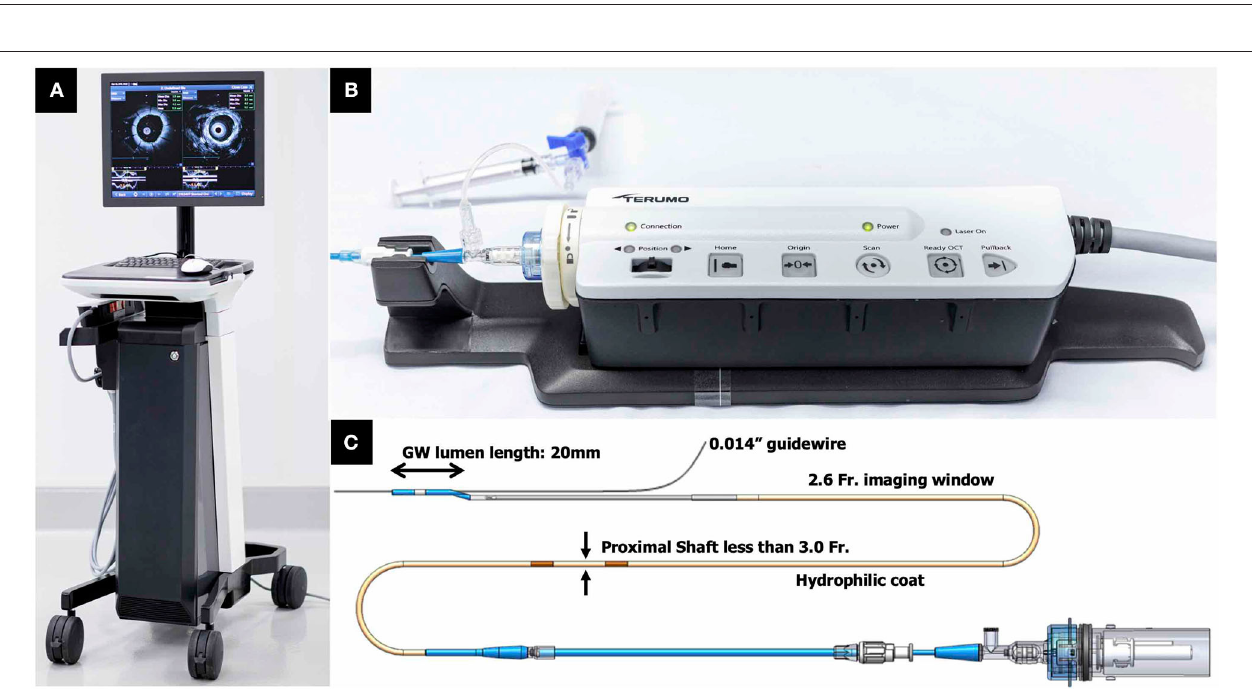
FIGURE 6 | TERUMO hybrid IVUS–OCT catheter system; external appearances. (A) A whole appearance of system body. (B) Interface module. (C) Catheter technical specifications. IVUS, intravascular ultrasound; OCT, optical coherence tomography.